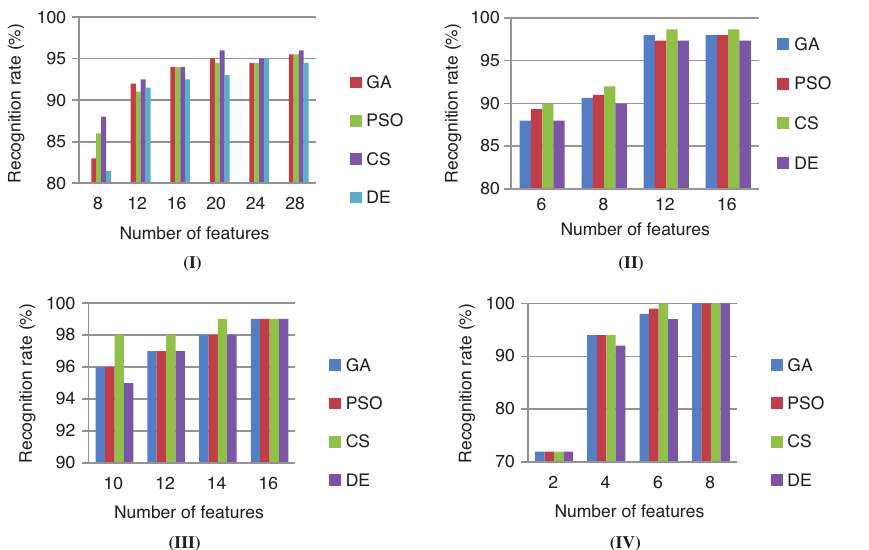
Figure 3: Recognition Rate for Different Numbers of Features for ORL Case 1: (I) 40 Classes, (II) 30 Classes, (III) 20 Classes, and (IV) 10 Classes.